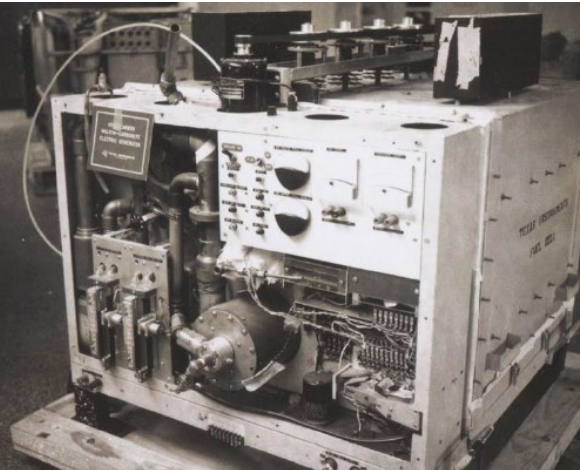
Figure 9. Texas Instruments 1 kW molten carbonate fuel cell. NMAH catalog no. 330031. Smithsonian